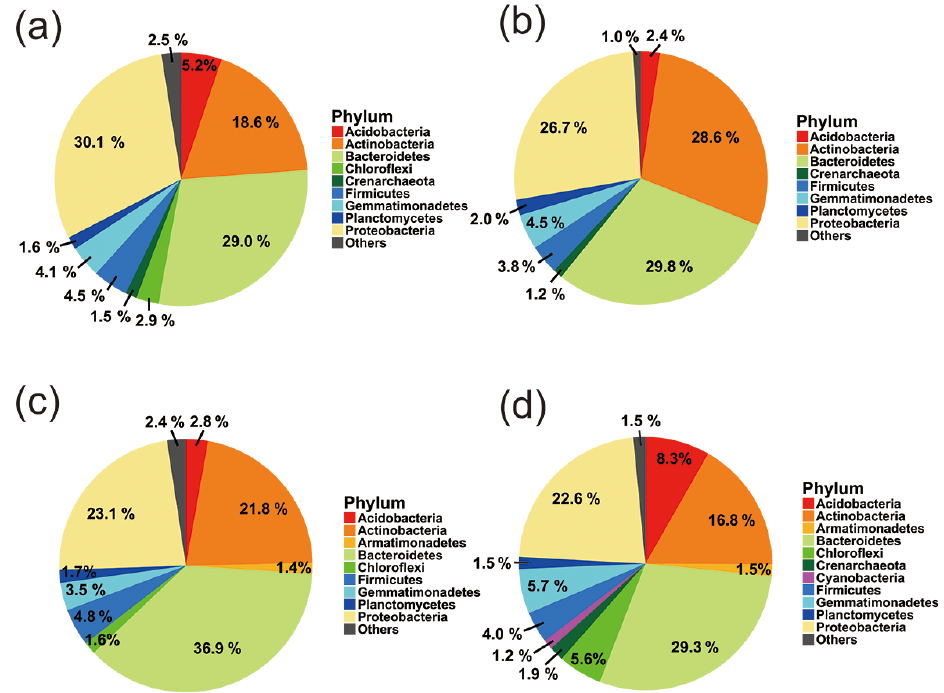
Figure 14. Variations in the bacterial community composition at the phylum level in (a) dust samples of Erenhot, (b) non-dust samples of Erenhot, (c) dust samples of R-DzToUb, and (d) non-dust samples of R-DzToUb.